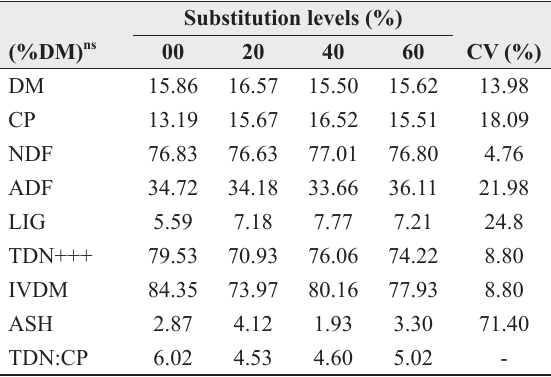
Chemical composition of extruded, in dry matter base (%DM) of Brachiaria brizanta cv Marandu,